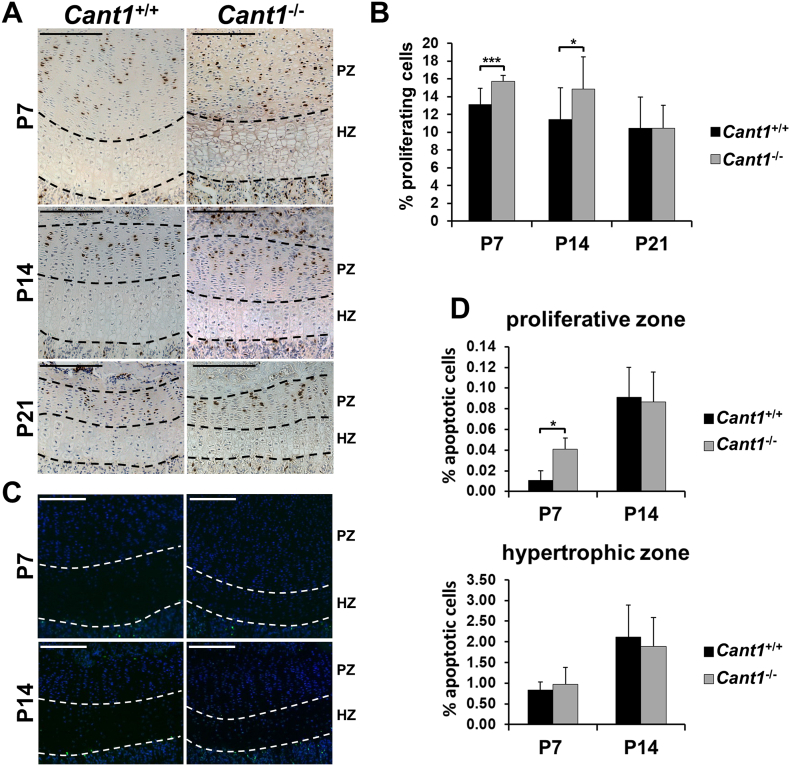
Proliferation and apoptosis are imbalanced in Cant1−/− growth plate. (A) BrdU assay on proximal tibia sections of Cant1−/− and Cant1+/+ mice. BrdU positive cells (brown) were only found in the proliferative zone. PZ = proliferative zone; HZ = hypertrophic zone; scale bar = 200 μm. (B) The percentage of proliferating chondrocytes was higher in P7 and P14 Cant1−/− proliferative zone. An average of five sections per animal were analysed. Data are reported as mean ± SD and significance was determined by Student's t-test, * P < 0.05; *** P < 0.001; n = 3. (C) Fluorescent TUNEL assay on proximal tibia sections of Cant1−/− and Cant1+/+ mice. TUNEL positive cells showed a green nucleus profile, while total cells were stained in blue by DAPI. PZ = proliferative zone; HZ = hypertrophic zone; scale bar = 200 μm. (D) The percentage of apoptotic chondrocytes was increased only in P7 Cant1−/− proliferative zone. An average of five sections per animal was analysed. Data are reported as mean ± SD and Student's t-test was performed, * P < 0.05; n = 3.